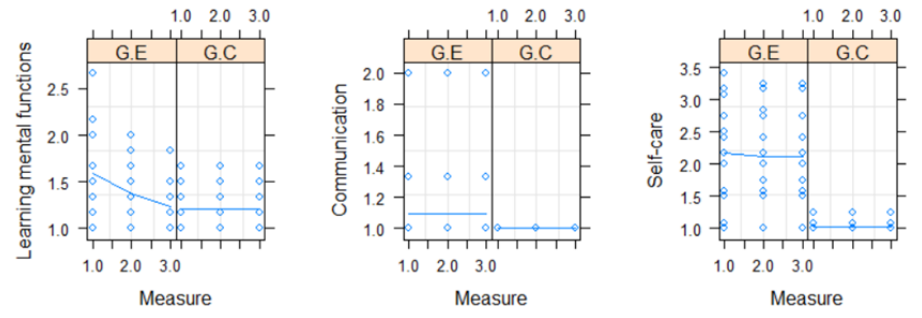
Figure 3. Evolution of each measure per group over the 3 evaluation moments and average user profile (solid line) per group.